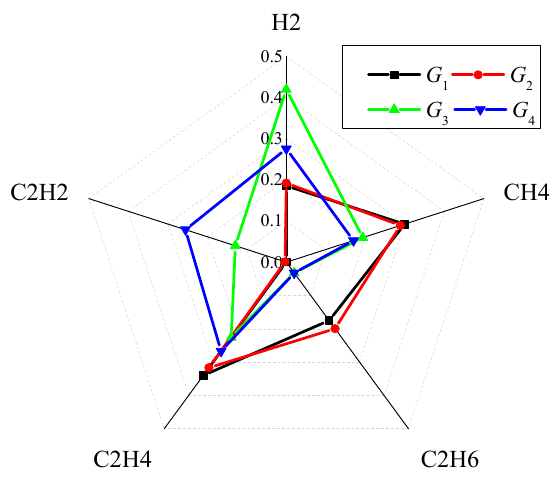
Figure 7. The important weight of each gas.